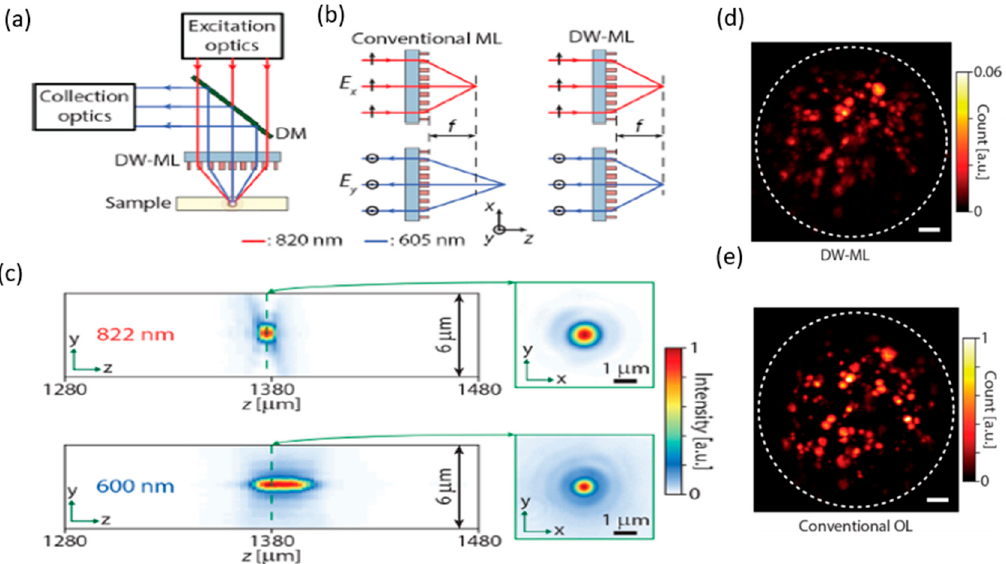
Figure 13. Metalens-based two-photon microscope system. ( a ) Schematic of a two-photon microscope employing a metasurface objective. ( b ) Schematic illustration of a conventional metasurface lens focusing light with different wavelengths to distinct focal lengths, and the DW-ML designed to focus 820 nm x -polarized light and 605 nm y -polarized light to the same focal distance of f . ( c ) ( Top ) Measured light intensity in the axial ( left ) and focal ( right ) planes for x -polarized 822 nm illumination. ( Bottom ) Same results as in the top figure for a y -polarized light source with a center wavelength of 600 nm and full width at half-maximum of approximately 10 nm. ( d ) Two-photon fluorescent microscope image captured by DW-ML. ( e ) captured using a conventional refractive objective, scale bars: 10 µm. (Reproduced from [91] with permission.)